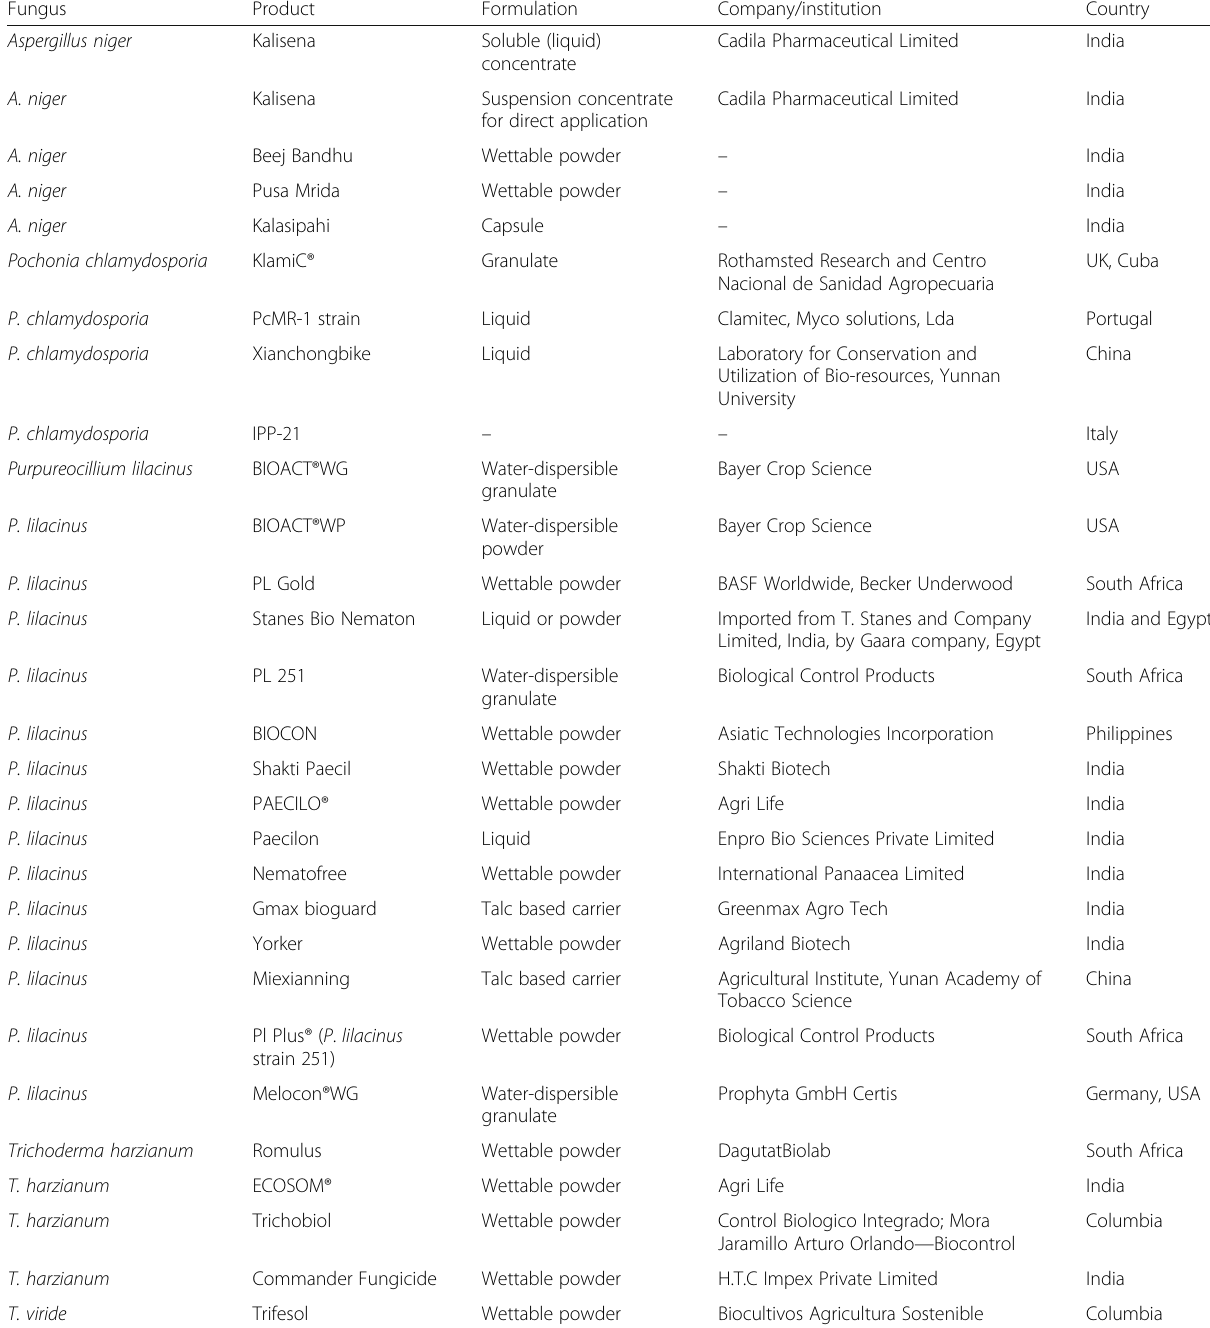
Table 3 List of commercial products of fungal biocontrol agents used in the nematode management (data are collected by the authors and based on Askary and Martinelli